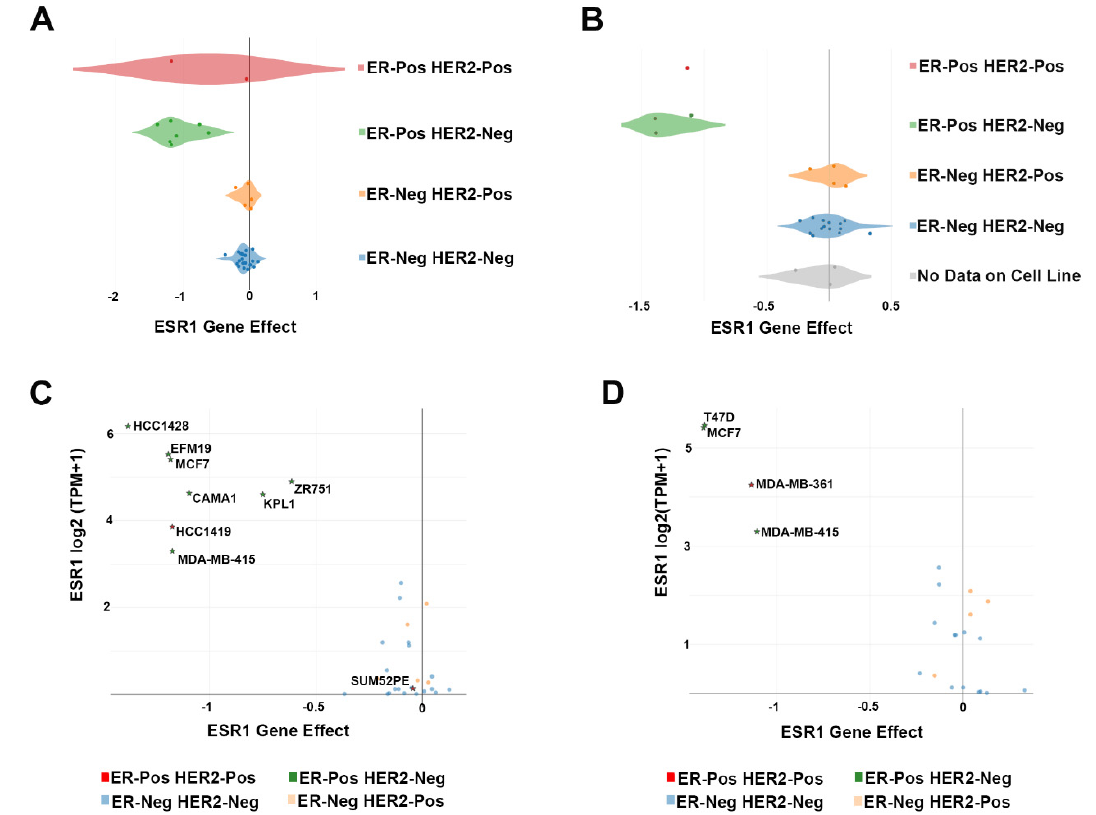
Figure 1. ESR1 essential gene behavior. ( A , B ) Box-plots showing the ESR1 essential gene score in all BC cell lines screened in Meyers et al. [6] and Behan et al. [7], respectively. A CERES score value ≤ − 0.5 indicates a significant e ff ect of the gene knockout. The gray box-plot represents BC cell lines for which no sub-subtype information is available. ( C , D ) Scatter plots showing the correlation between ESR1 gene e ff ect, indicated as the CERES score, and its expression, indicated as log 2 (TPM + 1) for all BC cell lines screened in Meyers et al. [6] and Behan et al. [7], respectively.